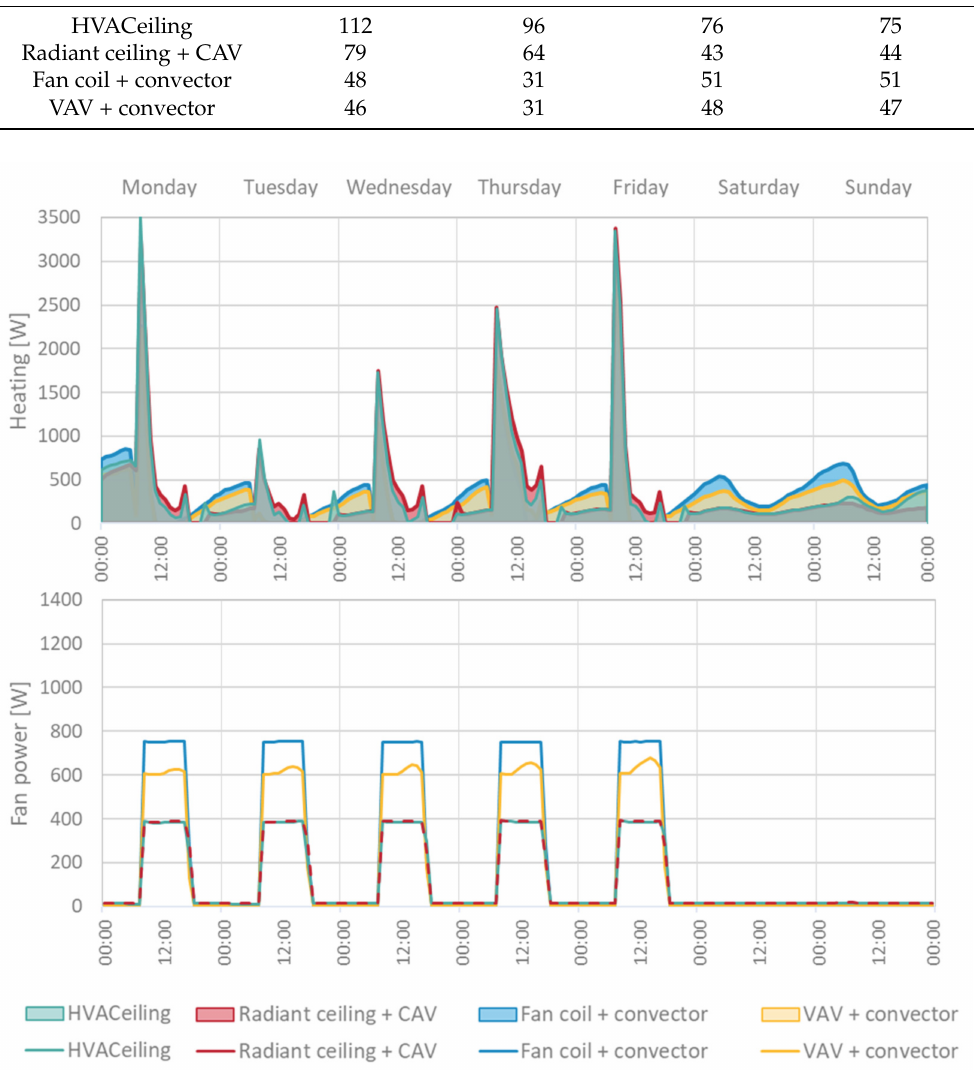
Figure 13. Peak electric heating and fan power in a cold week of March (8th − 14th). Sum of hourly values over one week. The peaks are high for all